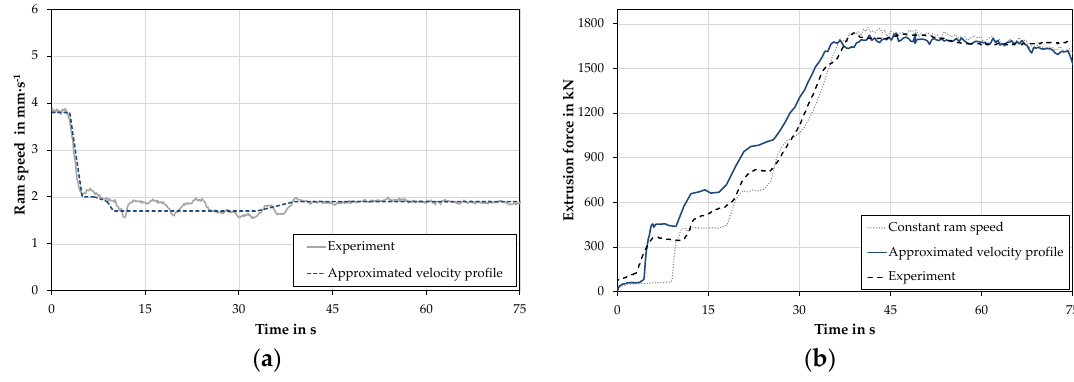
Figure 9. ( a ) Measured and approximated ram speed-time curve; ( b ) Extrusion force-time curve for a temperature of 480 °C, an extrusion ratio of 6:1 for constant and approximated ram speed.